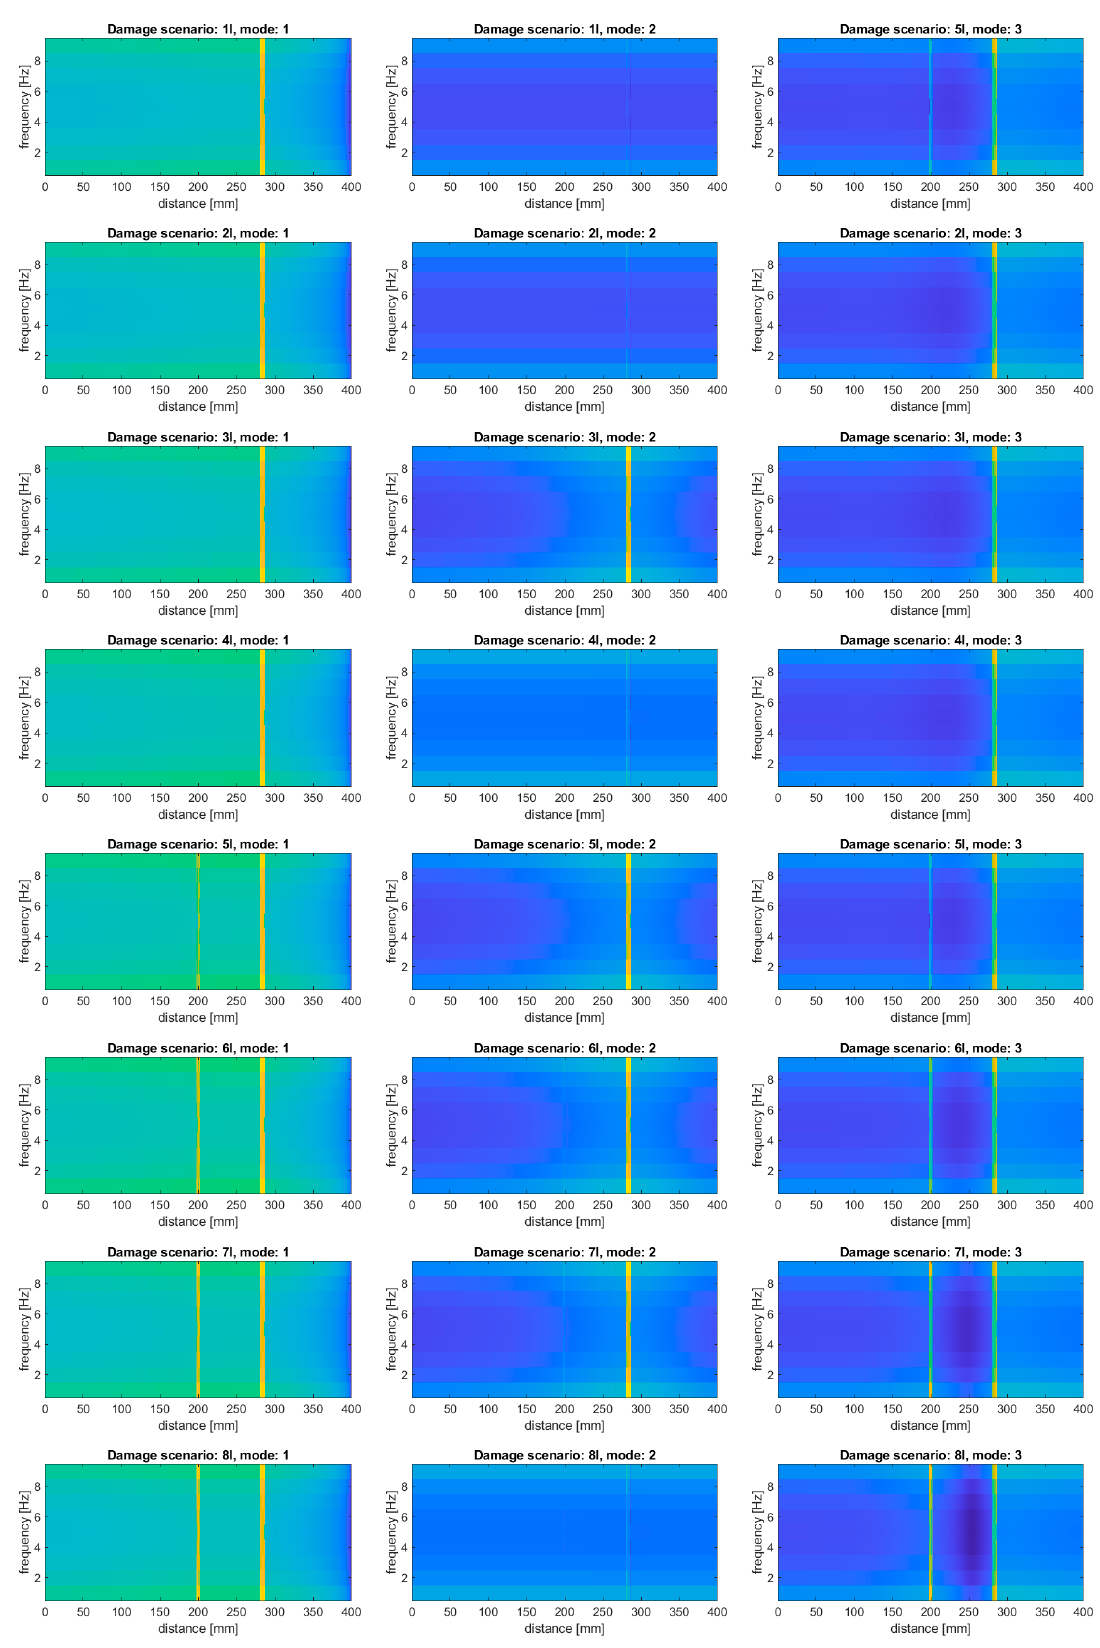
Figure 6. The results of the damage identification for the considered damage scenarios using baseline approach based on subtraction of the mode shapes before the transform.